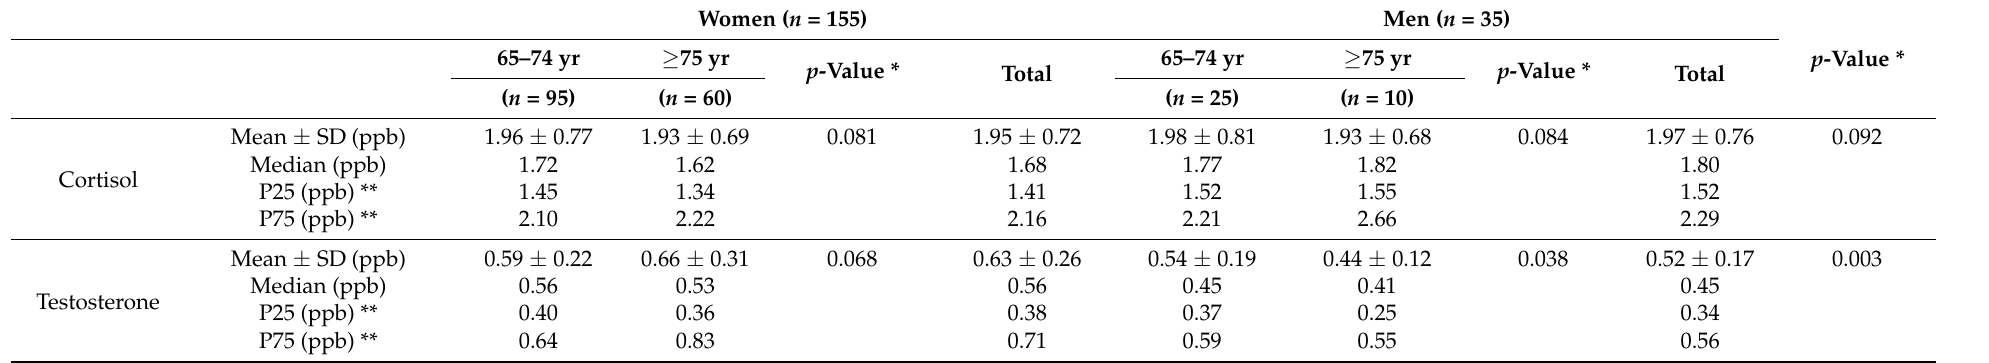
Table 3. Descriptive values for salivary cortisol and testosterone by different sex and age